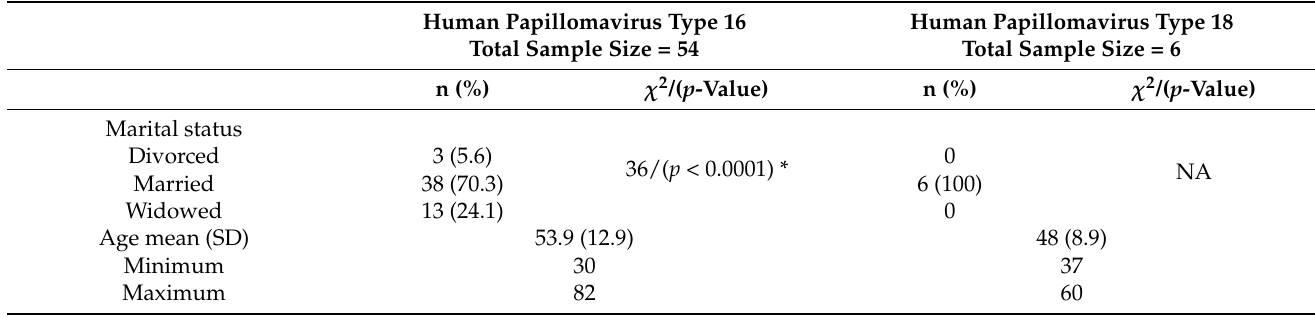
Table 6. Summary of the demographic and clinical characteristics of all our study